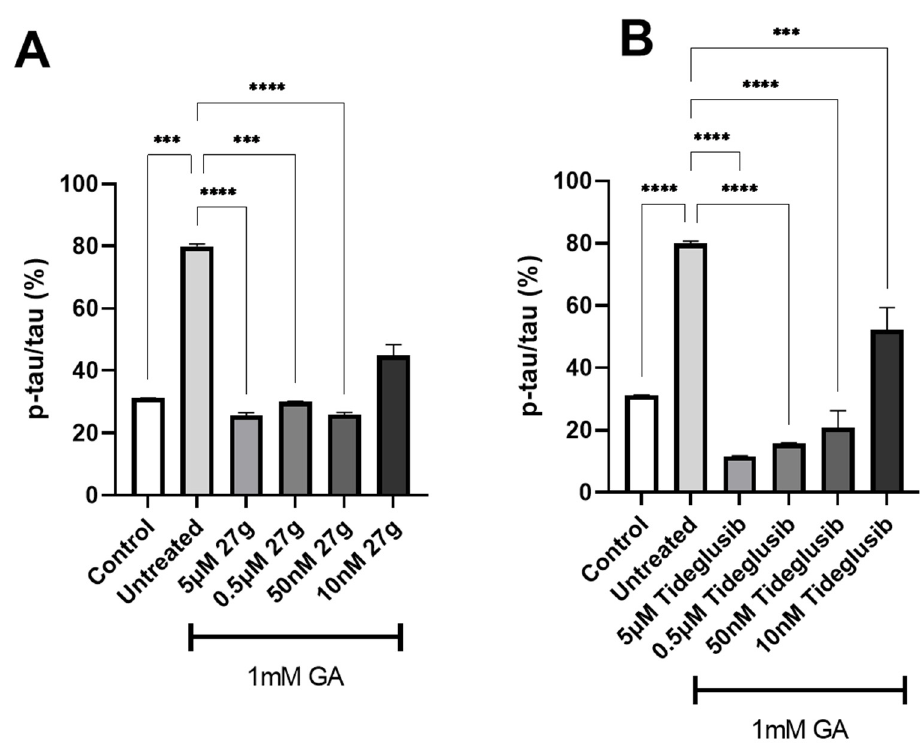
Figure 9. Reduction of Tau S396 phosphorylation after 27g treatment in 1 mM GA-exposed neurons. ( A ) Quantification of phosphorylation ratio pTau/tTau on S396 of 1 mM GA-treated SH-SY5Y-dif- ferentiated neurons after 27g treatment. ( B ) Quantification of phosphorylation ratio pTau/tTau on S396 of 1 mM GA-treated SH-SY5Y-differentiated neurons after Tideglusib treatment. Kruskal–Wal- lis test followed by Dunn’s post-hoc was used to compare the differences between different groups. Data are expressed as mean ± SEM, n = 3 with at least 5 repetitions per experiment, *** p < 0.001, **** p < 0.0001.